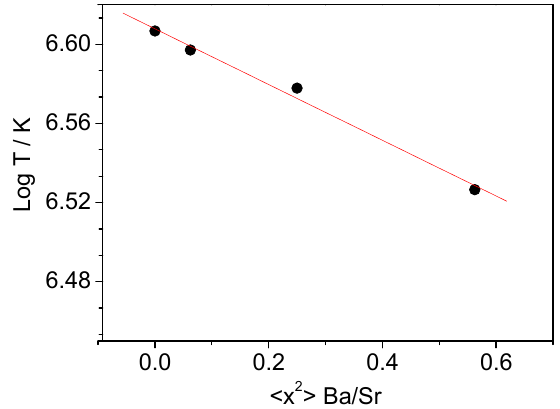
Figure 7. Variation of the Néel temperature with x across the Sr 1 − x Ba x FeO 2 F series.